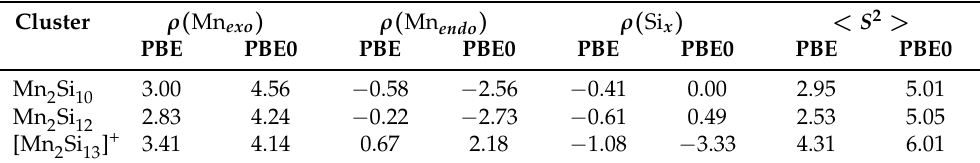
Table 2. Total energies ( E ) and number of configuration state functions (CSFs) obtained from Hartree Fock (HF), restricted (RAS), and generalized (GAS) active space calculations for Mn and [Mn Si ] + . All energies are given in Hartree units. 2 13 Cluster HF RAS GAS E CSFs E E